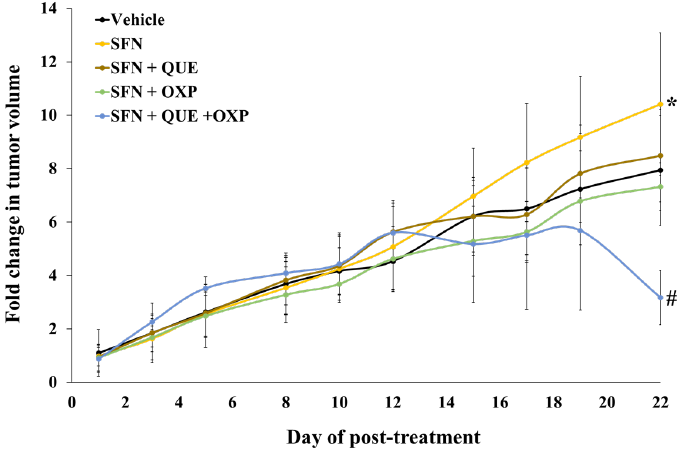
Figure 6. A combination of QUE, SFN, and OXP suppressed HCT116 xenograft tumor growth. QUE suppressed the tumor growth of HCT116 cells in vivo. The xenograft tumors were established by subcutaneously transplanting 3 × 10 6 HCT116 cells to BALB/c mice. The xenograft tumor-bearing mice were treated with QUE (50 mg/kg BW), OXP (10 mg/kg BW), SFN (5 mg/kg BW), and their combinations as designated by intraperitoneal injection. Tumor growth in xenografts was measured three times per week. Error bars represent mean ± SD from four tumor samples ( n = 4). A significant difference is indicated by asterisk, *, and hashtag, #, compared with vehicle and SFN-treated group ( p < 0.05, Student’s unpaired t -test).